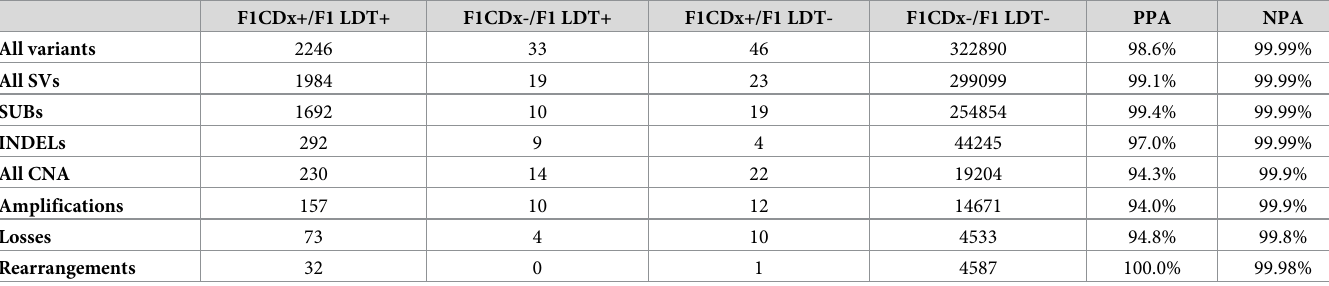
Table 13. Concordance of F1CDx and FoundationOne 1 for platform-wide